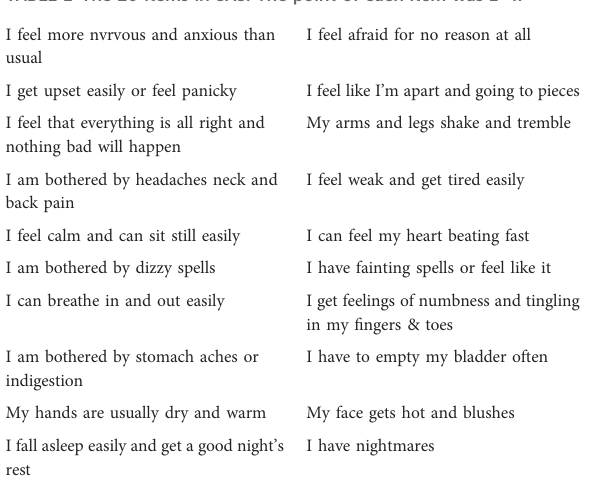
TABLE 1 The 20 items in SAS. The point of each item was 1 – 4.